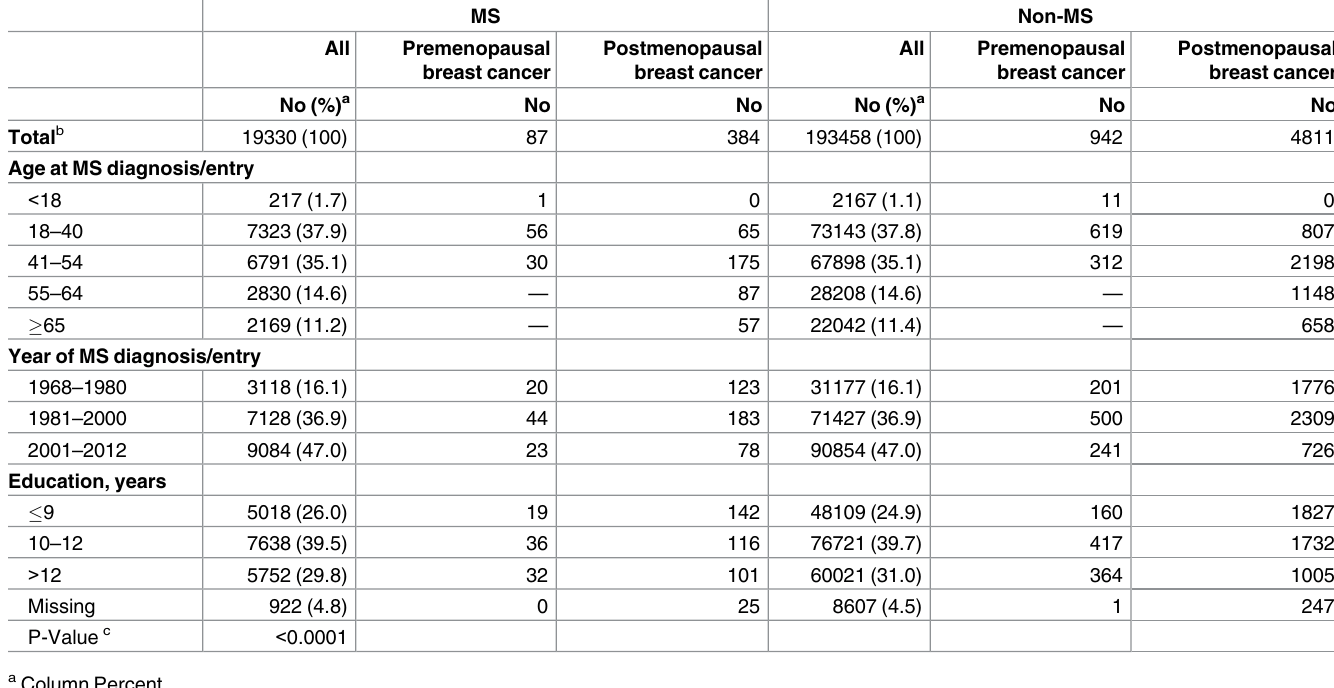
Table 1. Characteristics of MS patients and non-MS matched